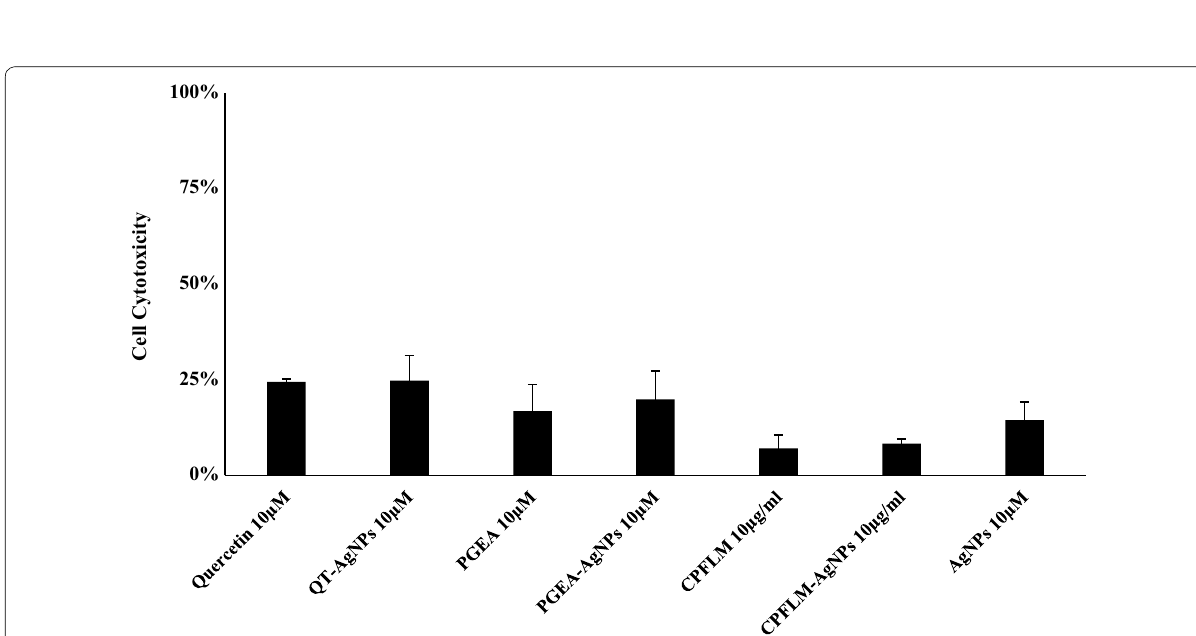
Fig. 7 QT, PGEA, CPFLM and their silver nanoconjugates showed limited cytotoxicity to HaCaT cells. Briefly, 10 μM of test samples were added to HaCaT cells and incubated for 24 h at 37 °C in a 5% CO 2 incubator. The compounds and nanoparticles showed less than 30% cytotoxicity at 10